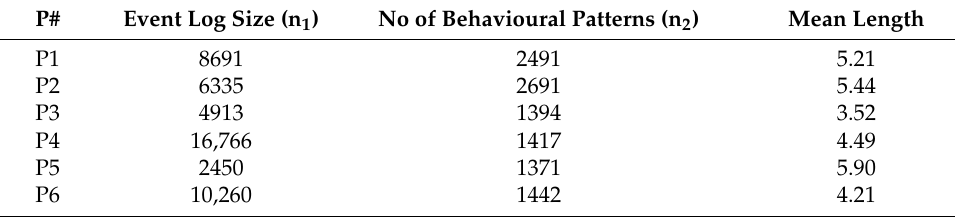
Table 3. Behavioural patterns summary ( n =